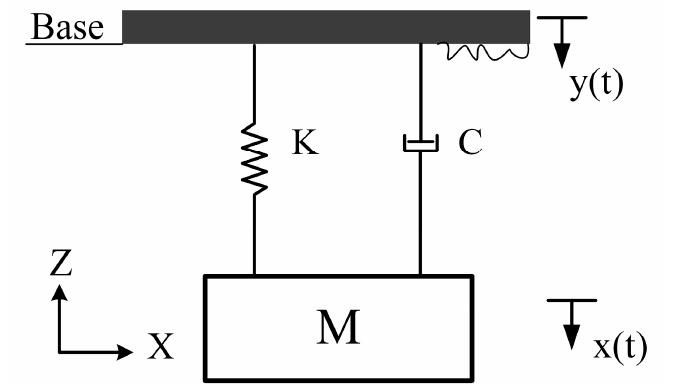
Figure 4. Single degree-of-freedom system model.